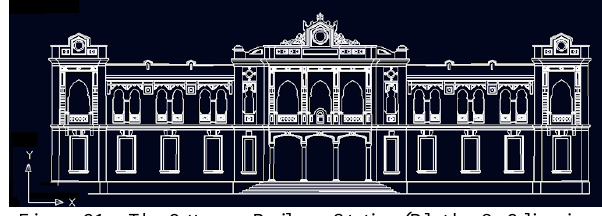
Figure 21 – The Ottoman Railway Station (Plot by C. Olimpio from five panoramas)